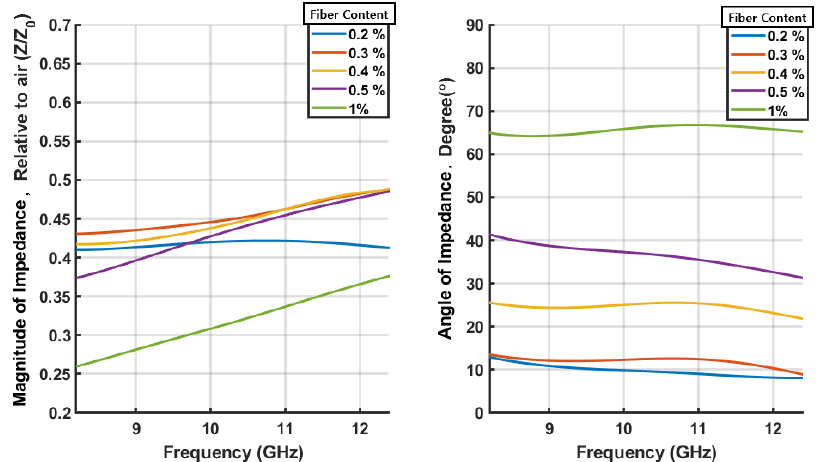
Figure 9. Impedance of each specimen of the SFRC.